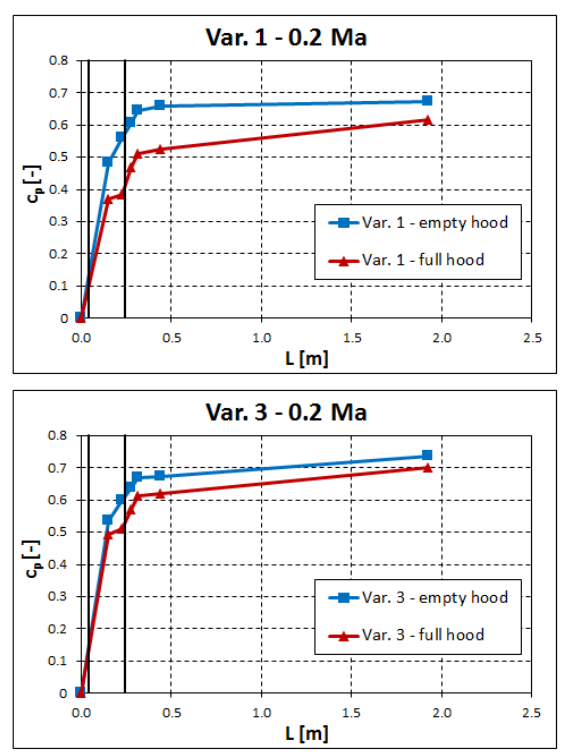
Fig. 17. Comparison of pressure recovery coefficient of the full and empty hood .